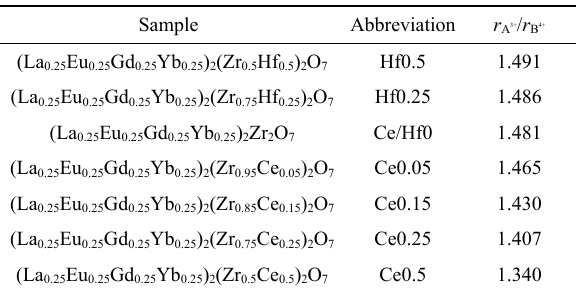
Table 1 Compositions and r A 3+ / r B 4+ of A 2 B 2 O 7 high- entropy